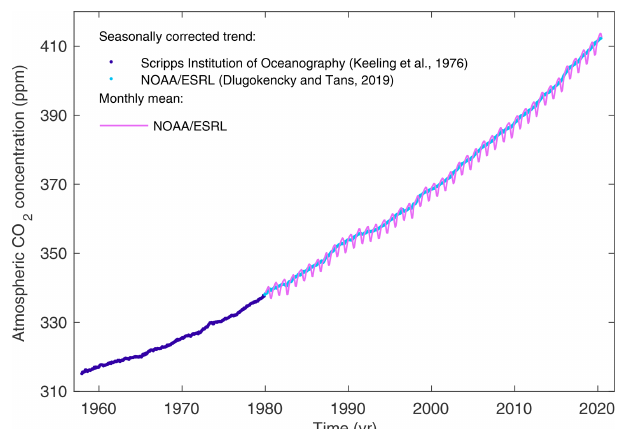
Figure 1. Surface average atmospheric CO 2 concentration (ppm). The 1980–2019 monthly data are from NOAA/ESRL (Dlugokencky and Tans, 2020) and are based on an average of direct atmospheric CO 2 measurements from multiple stations in the marine boundary layer (Masarie and Tans, 1995). The 1958–1979 monthly data are from the Scripps Institution of Oceanography, based on an average of direct atmospheric CO 2 measurements from the Mauna Loa and South Pole stations (Keeling et al., 1976). To take into account the difference of mean CO 2 and seasonality between the NOAA/ESRL and the Scripps station networks used here, the Scripps surface av- erage (from two stations) was de-seasonalized and harmonized to match the NOAA/ESRL surface average (from multiple stations) by adding the mean difference of 0.542ppm, calculated here from overlapping data during